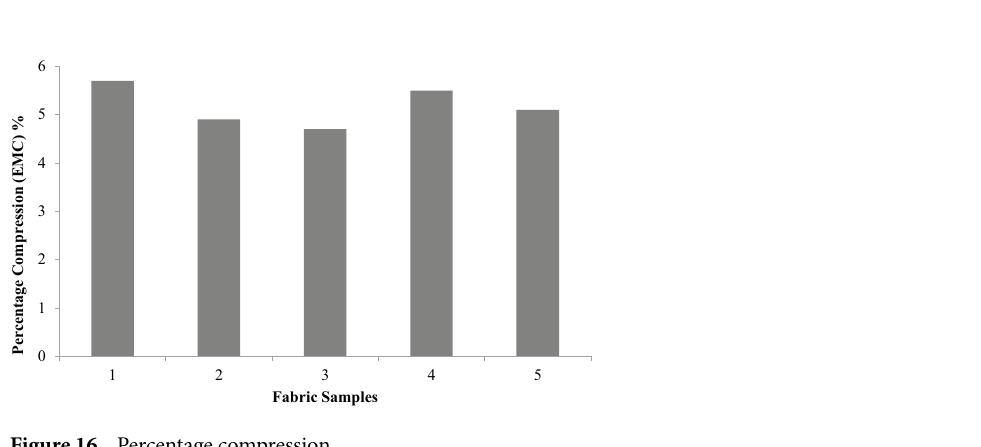
Figure 16. Percentage